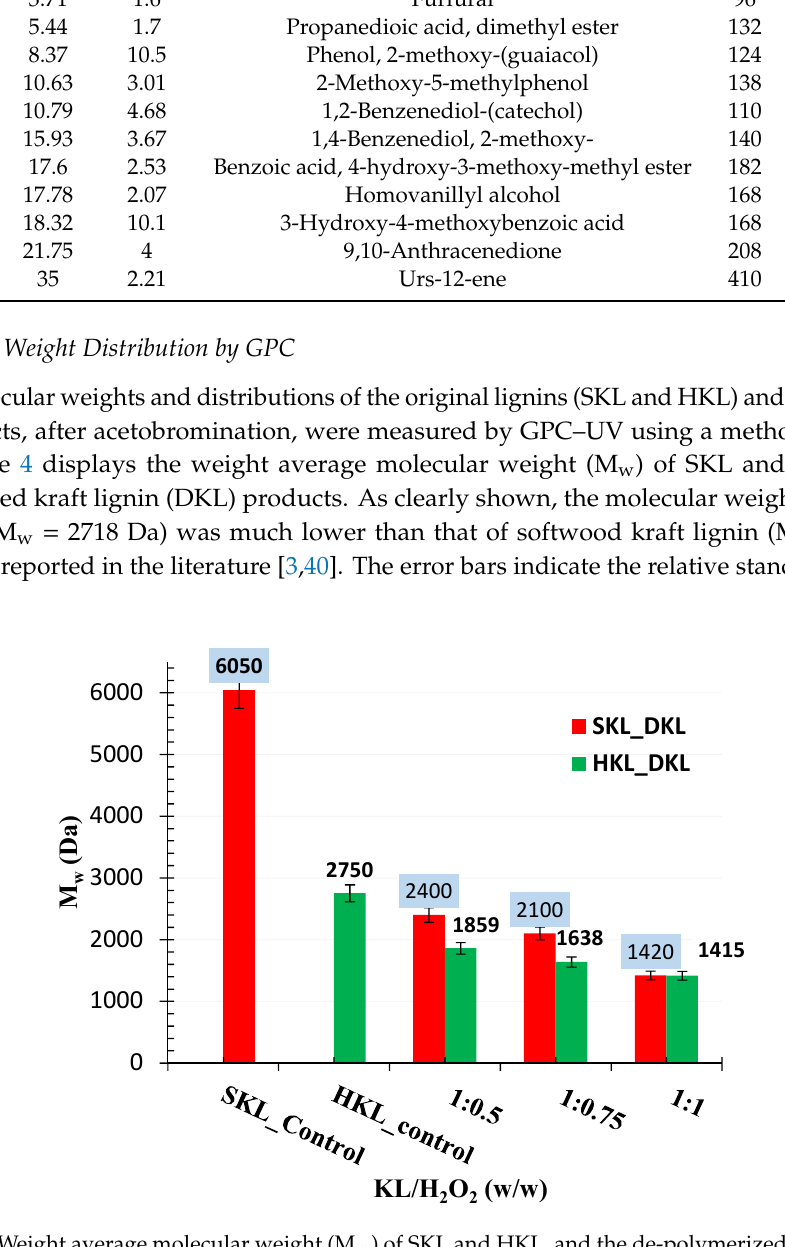
Figure 4. Weight average molecular weight (M w ) of SKL and HKL, and the de-polymerized kraft lignin (DKL) products at different lignin to peroxide ratios.